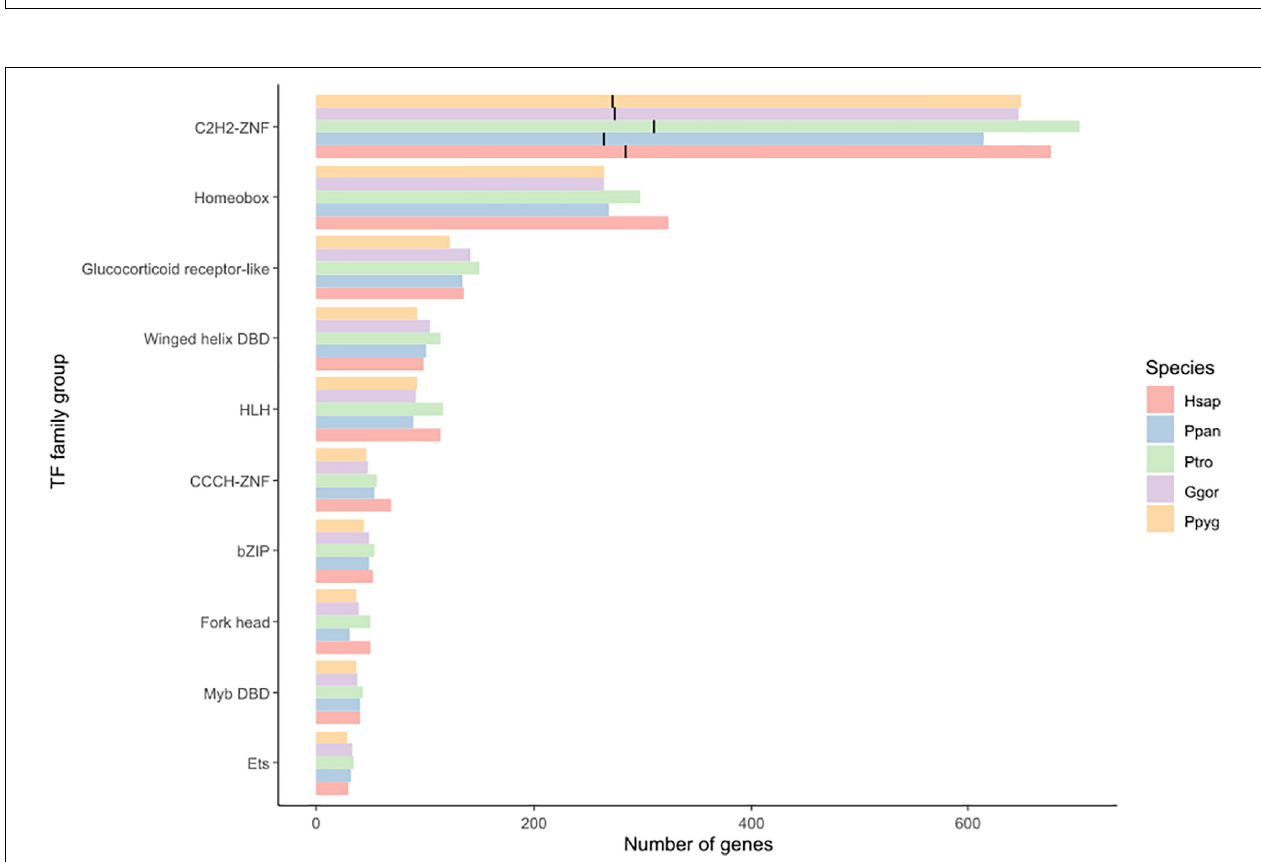
FIGURE 2 | The 10 most abundant families of great apes GRFs. Within the C2H2-ZNF family, the number of KRAB-ZNF genes is marked with a black bar. Species abbreviations are the same as in Figure 1A .